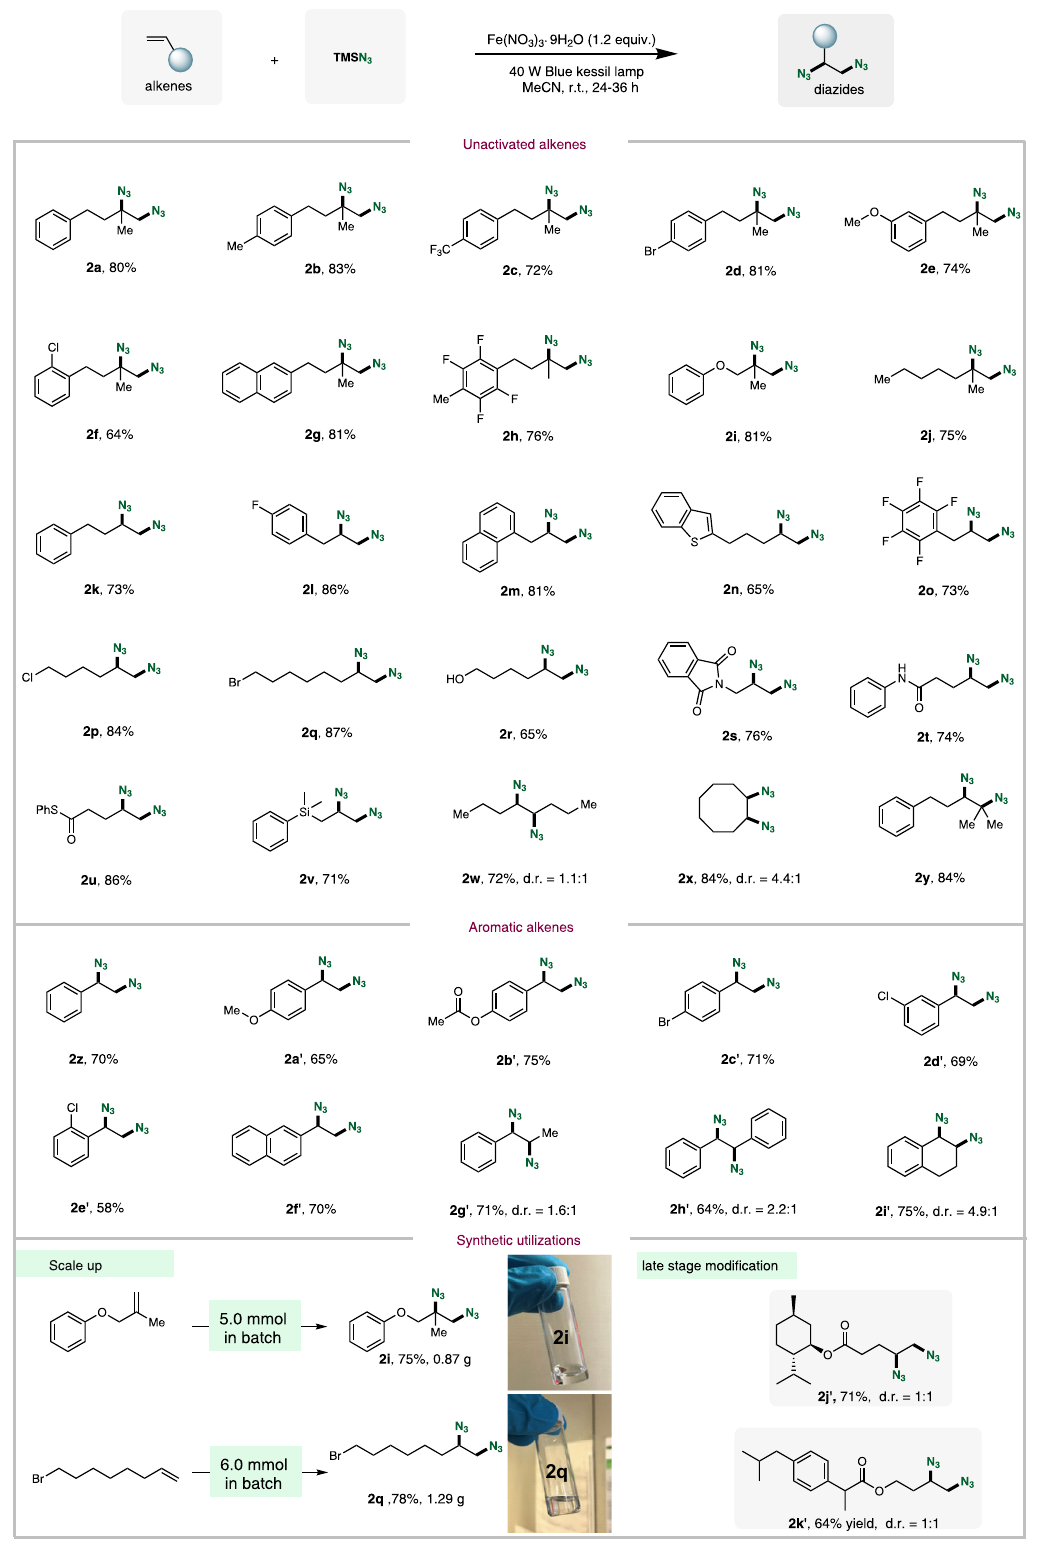
Fig. 2 | Scope of alkenes and synthetic utilization. Standard conditions: alkenes (0.20mmol, 1.0 equiv), TMSN 3 (1.0mmol, 5.0 equiv), Fe(NO 3 ) 3 ·9H 2 O (0.24mmol, 1.2 equiv) and MeCN (2mL), blue LEDs, 24 – 36h, isolated yield. d.r. diastereomeric